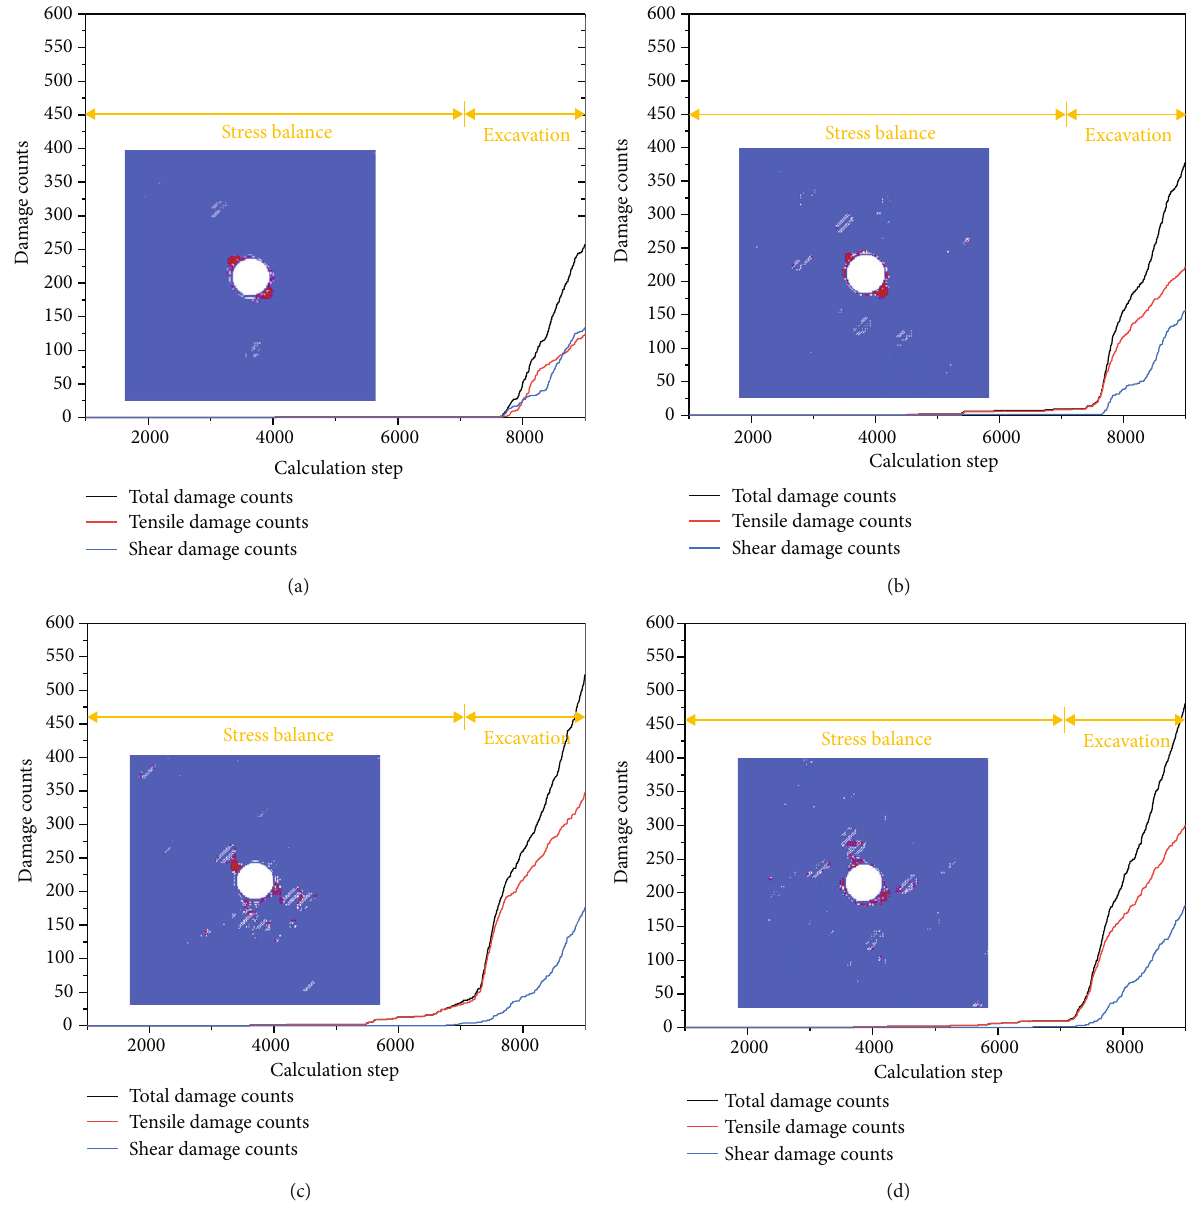
Figure 10: Excavation damage counts under di ff erent fi ssure numbers. (a) N = 10 . (b) N = 20 . (c) N = 30 . (d) N = 40